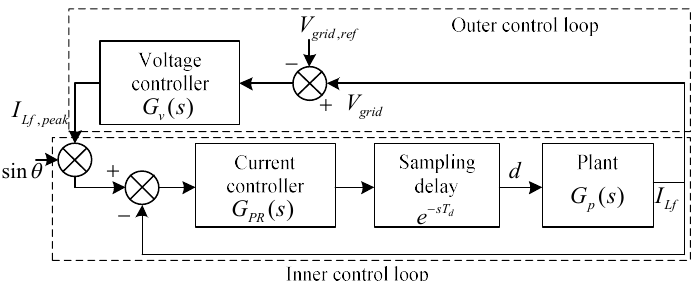
Figure 2. Inner current control loop and outer control loop for grid-connected inverter control.